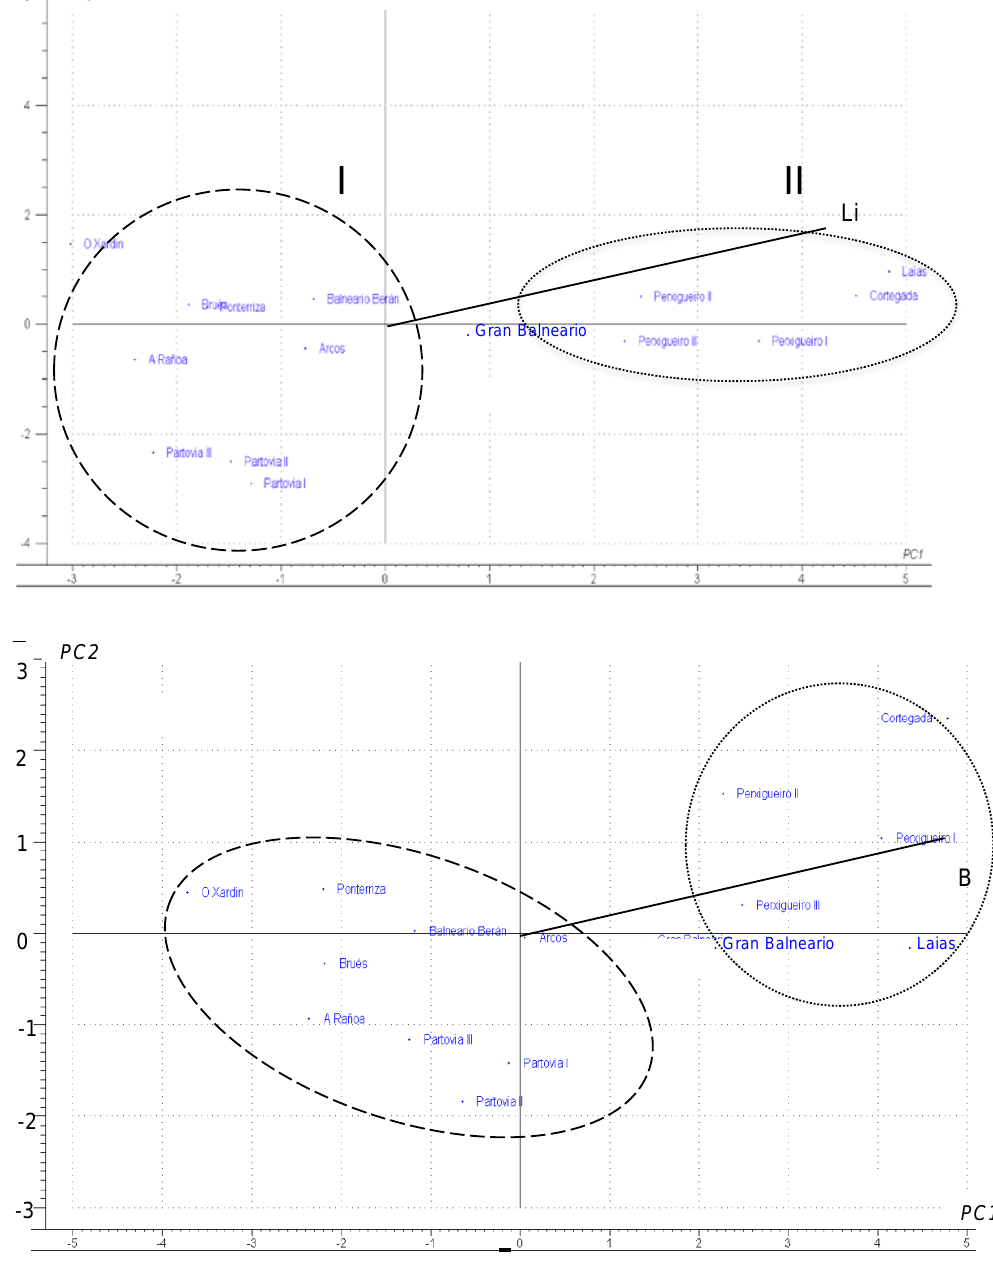
Fig. 4. Partial Least-squares regression plots for the selected samples, showing the X loading weights and the Y loadings for Li and B. Regression coefficient of 0.9988 and 0.8996 for Li and B are obtained. Two clusters are also distinguised depending on Li and B